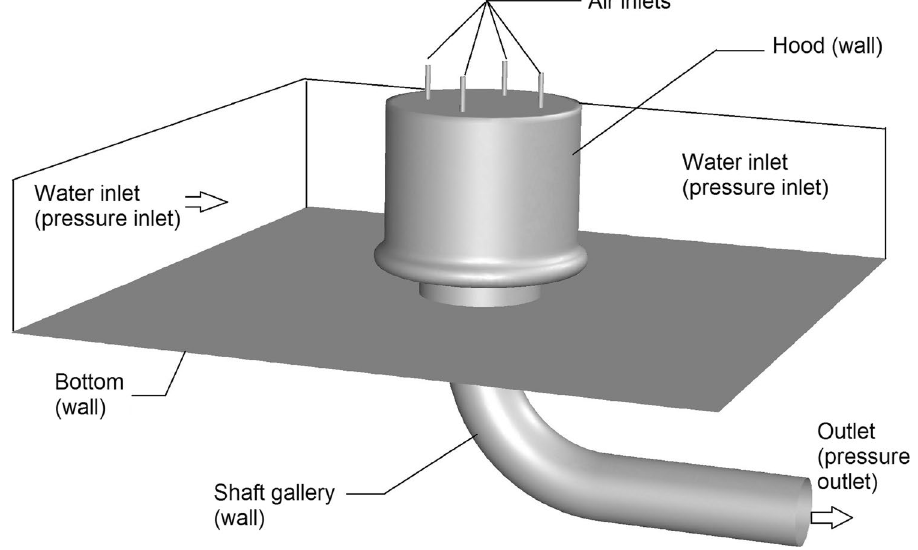
Fig. 1 3D geometry and bound- ary conditions of the numerical